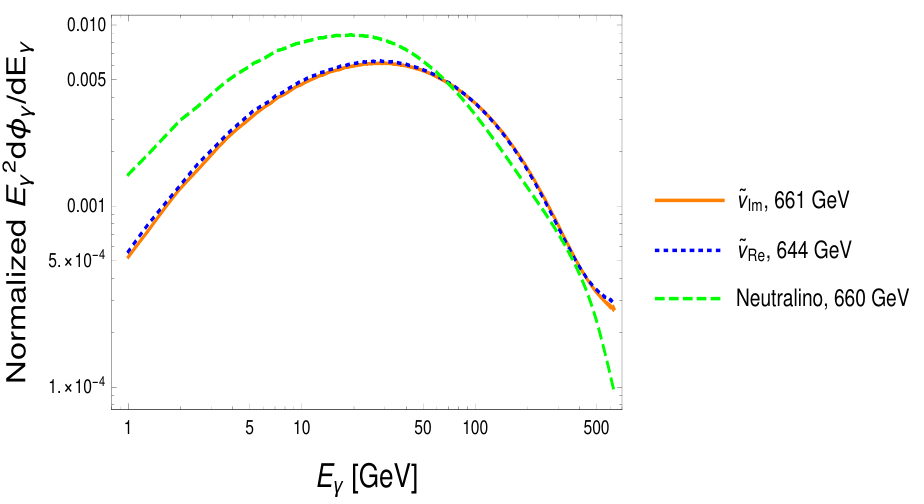
Figure 8 . Di(cid:11)erential (cid:13)ux of (cid:13) -ray secondary radiation induced by DM DM ! W + W as a function of the photon energy, with (cid:12)xed DM mass, for our benchmark CP-even (blue) and CP-odd (orange) sneutrinos. The corresponding distribution for a neutralino is also given for comparison (green). Normalisation is the same for all